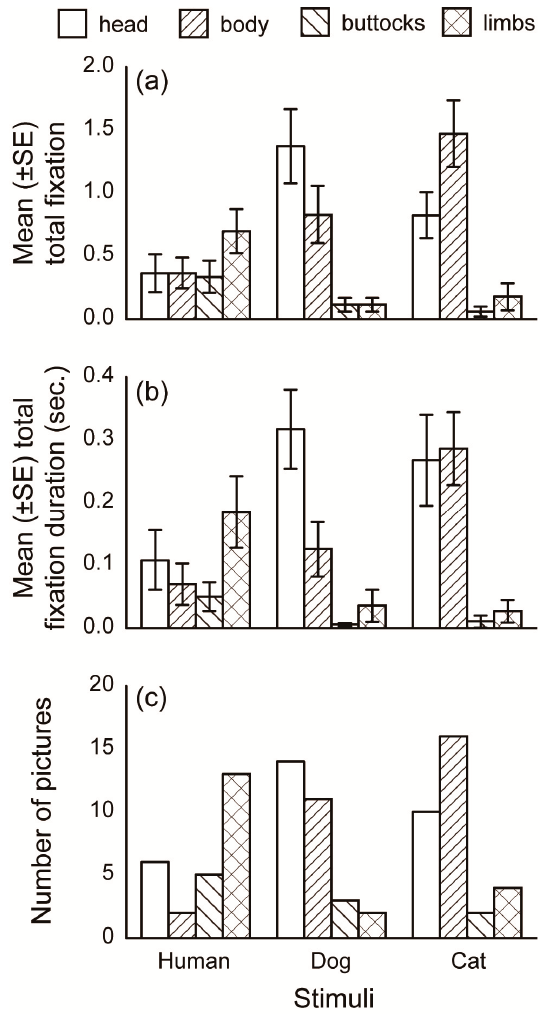
Figure 4. Mean ( ± SE) fixation number, mean ( ± SE) total fixation duration, and number of pictures Figure 4. Mean (± SE) fixation number, mean (± SE) total fixation duration, and number of pictures categorized into each first gazed AOI for each picture species. categorized into each first gazed AOI for each picture Table 2. Generalized Linear Mixed Model results.